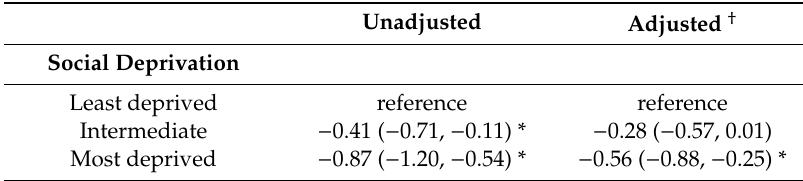
Table 4. Mean di ff erence in diet quality score (95% CI) of participants living in more socially-deprived areas versus least deprived areas, in unadjusted and adjusted LMMs.